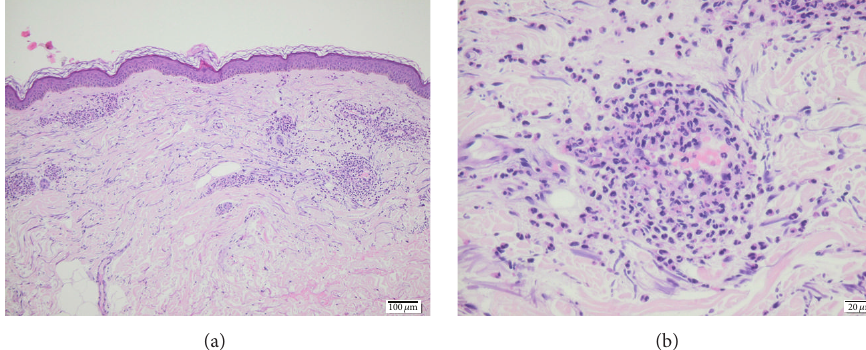
Figure 1: Histopathological sections of the patient showing leukocytoclastic vasculitis. Table 1: Patients with urticarial vasculitis treated with